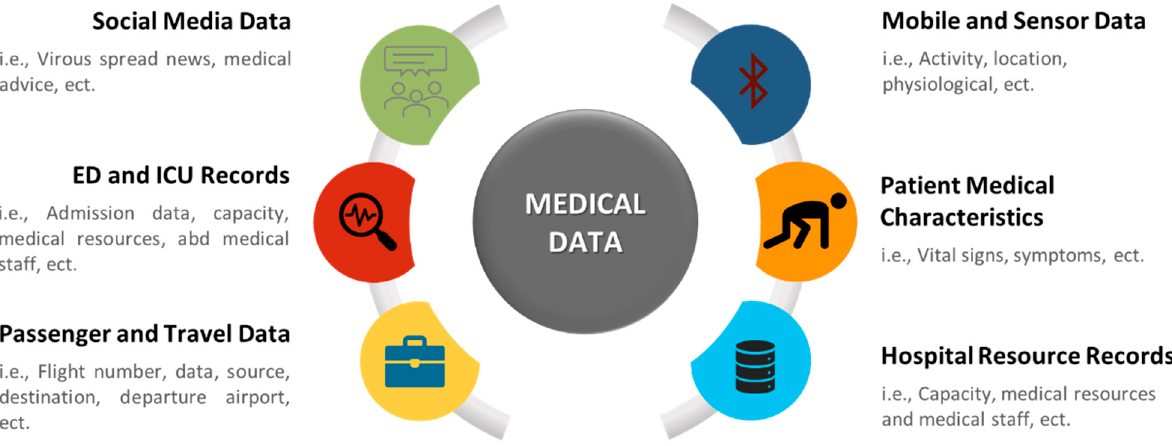
Figure 2. Type and source of medical data.